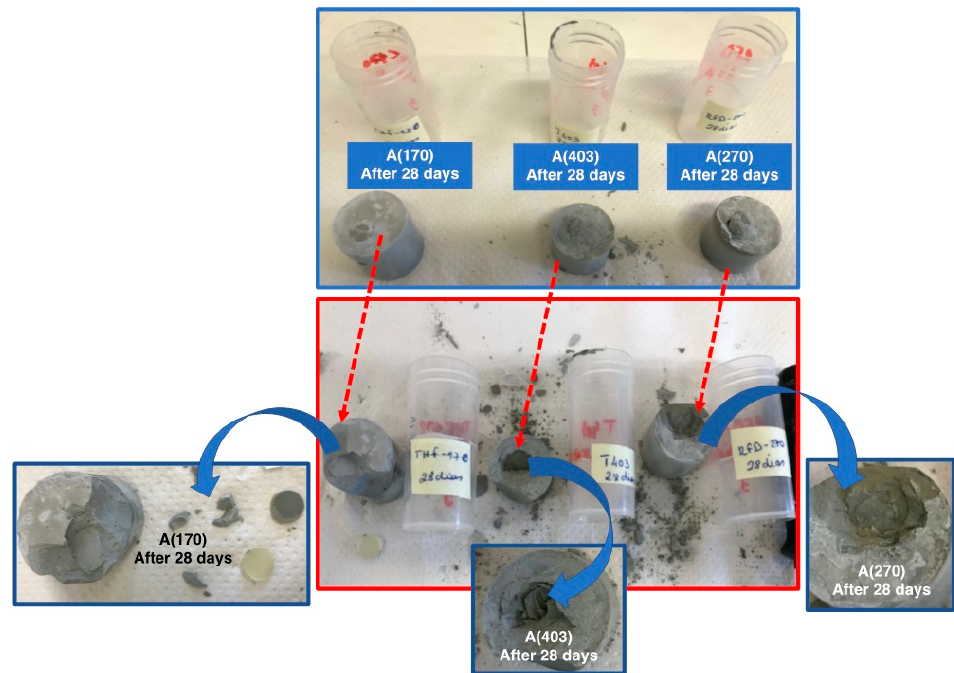
Figure 8. OIH samples (A(270), A(403), and A(170)) after 28 days immersed in cement paste with a w / c = 0.5.